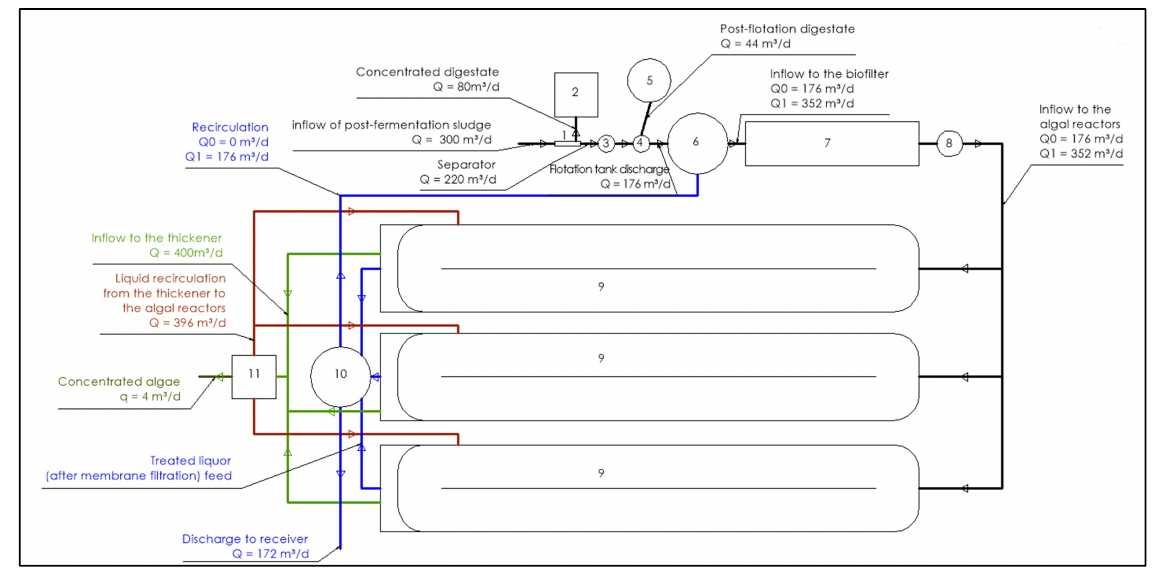
Figure 8. Process diagram of the system for producing microalgal biomass based on digestate (1—separator; 2—field of the thickened sludge; 3—digestate tank; 4—flotator; 5—post-flotation diges-